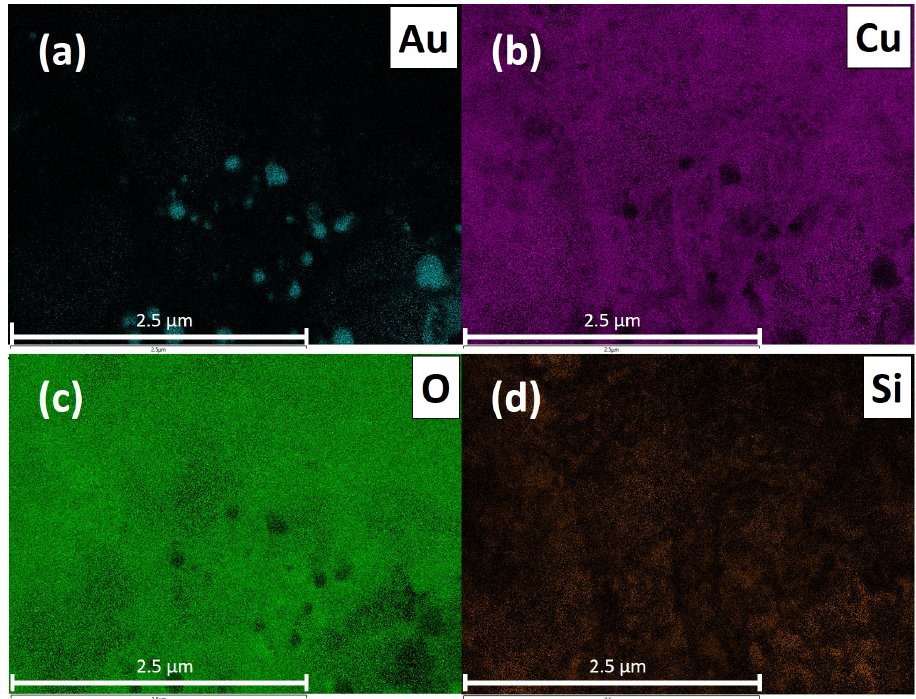
Figure 4. Elemental mapping of a 4 µm × 4 µm section on the copper oxide surface with 5 keV (primary beam energy). ( a ) Au elemental map, ( b ) Cu elemental map, ( c ) O elemental map and ( d ) Si elemental